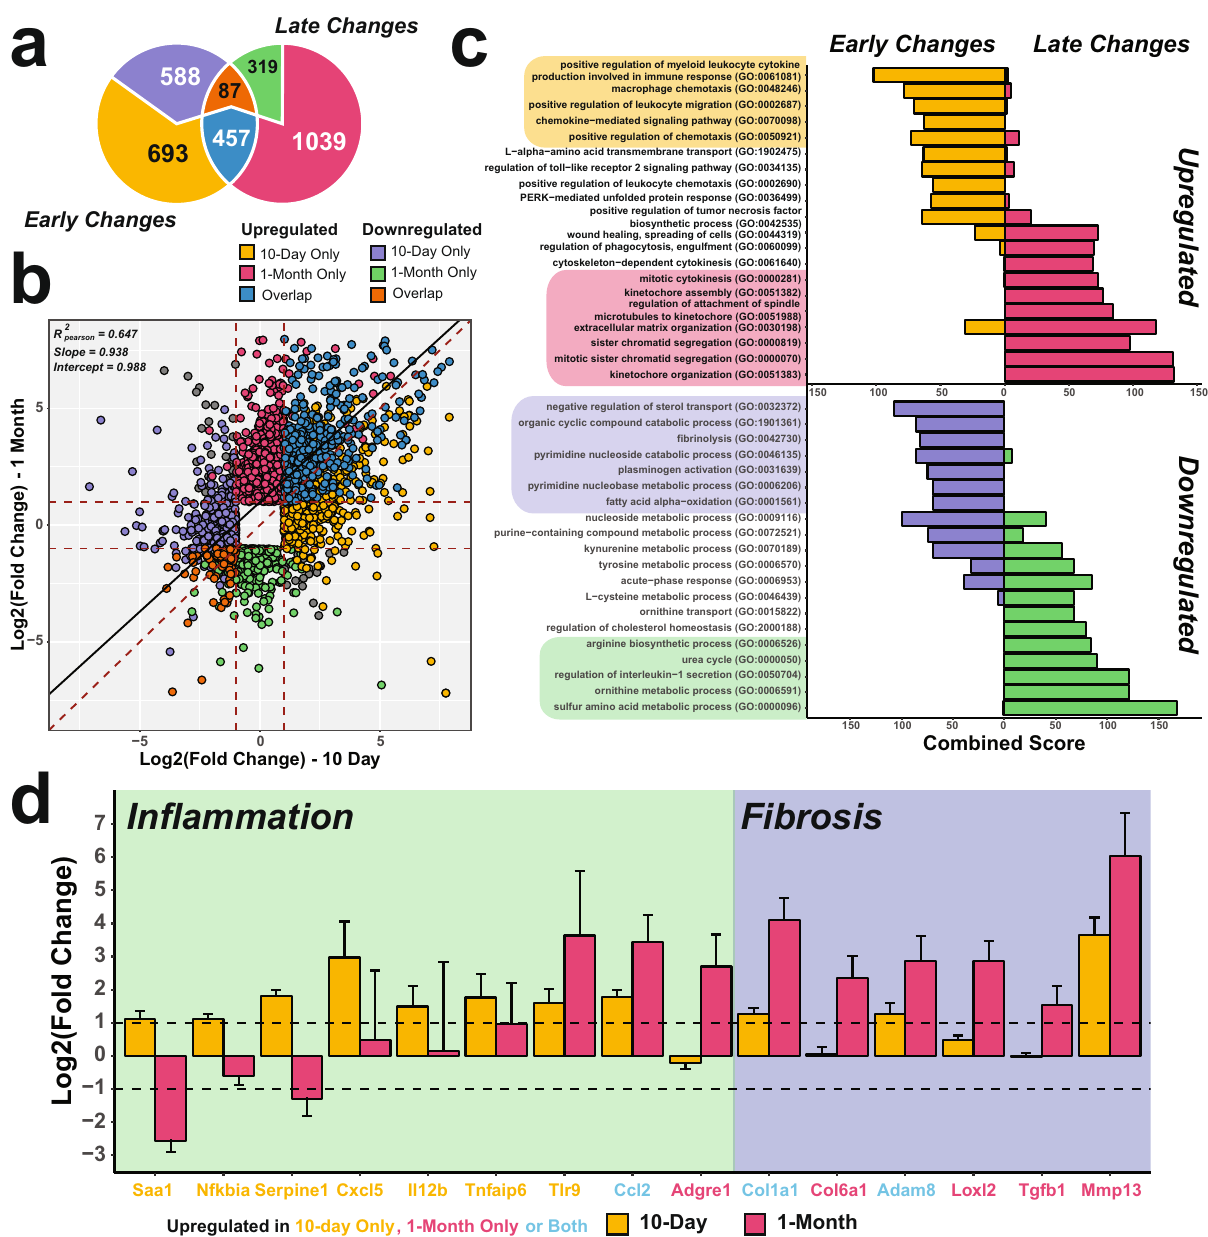
Fig. 4 | Gene expression signatures in SRSF1 HKO hepatocytes transition from an early in fl ammatory to a late fi brotic phase. a Overlap of differentially expressed genes from RNA-seq (FDR<0.05, Wald test as described DESeq2; | Log 2 (Fold Change)| ≥ 1) in 10-day (early) and 1-month (late) old SRSF1 HKO hepa- tocytes( n =2samples/condition). b ScatterplotshowingthedistributionofmRNA abundance fold changes in SRSF1 HKO with respect to controls at both early and late timepoints. c Gene ontology (GO) terms of upregulated and downregulated